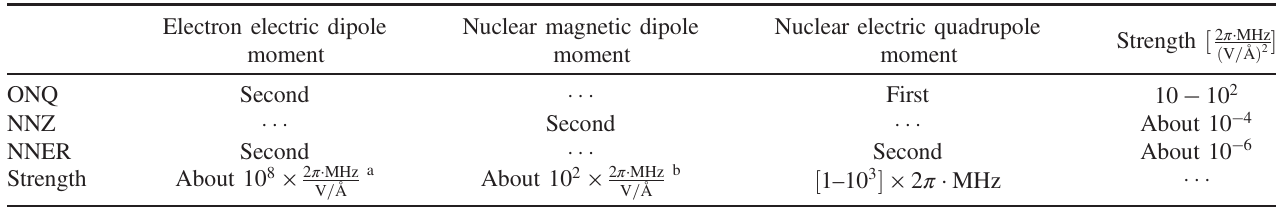
TABLE I. Orders of interactions for various NLO effects that could couple optical photons and nuclear